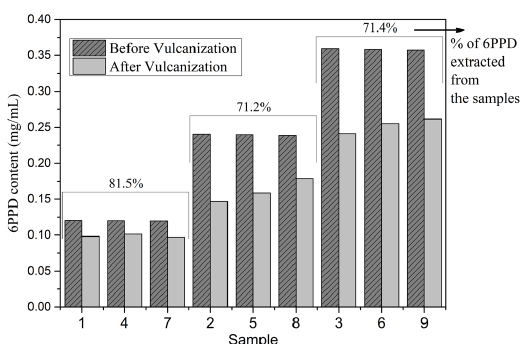
Figure 2. 6PPD content measured after vulcanization